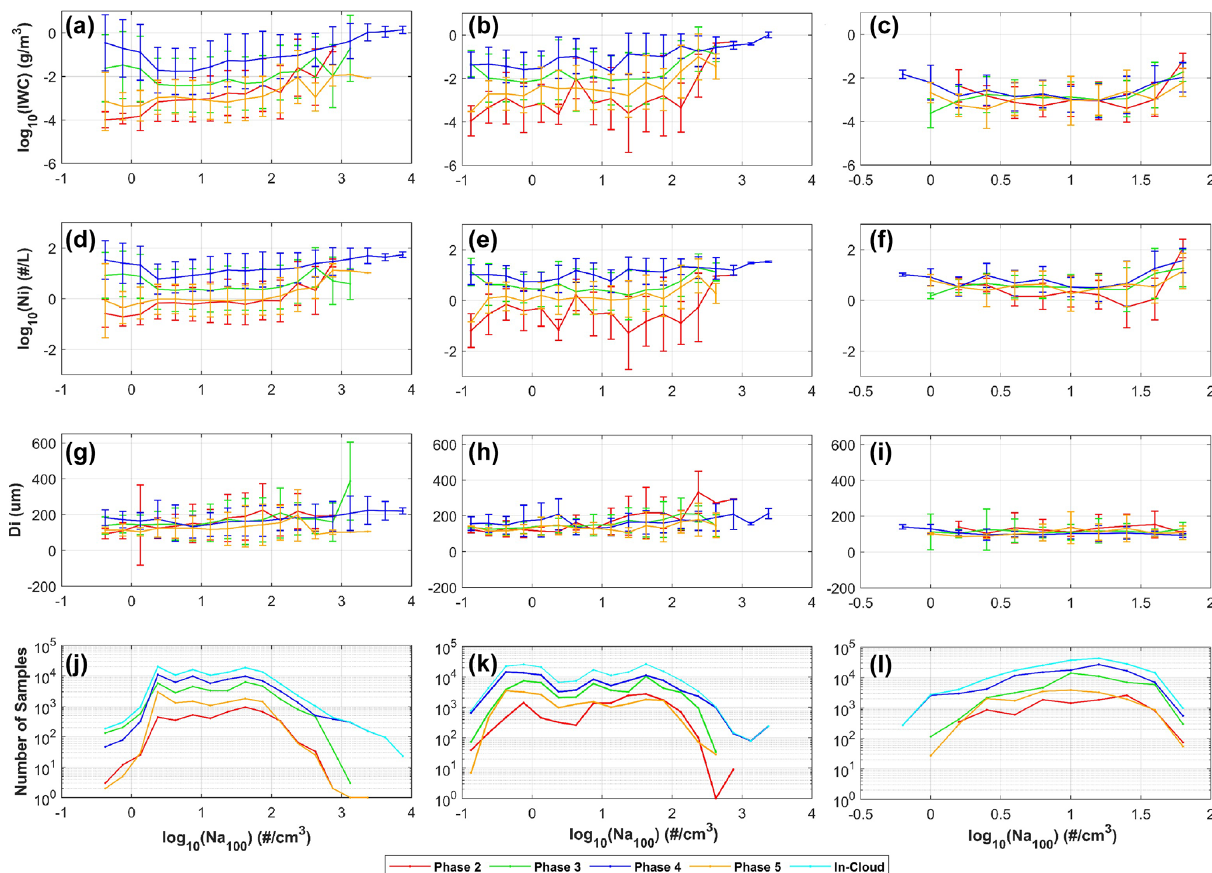
Figure 8. Similar to Fig. 7, except for plotting cloud microphysical properties against log 10 (Na 100